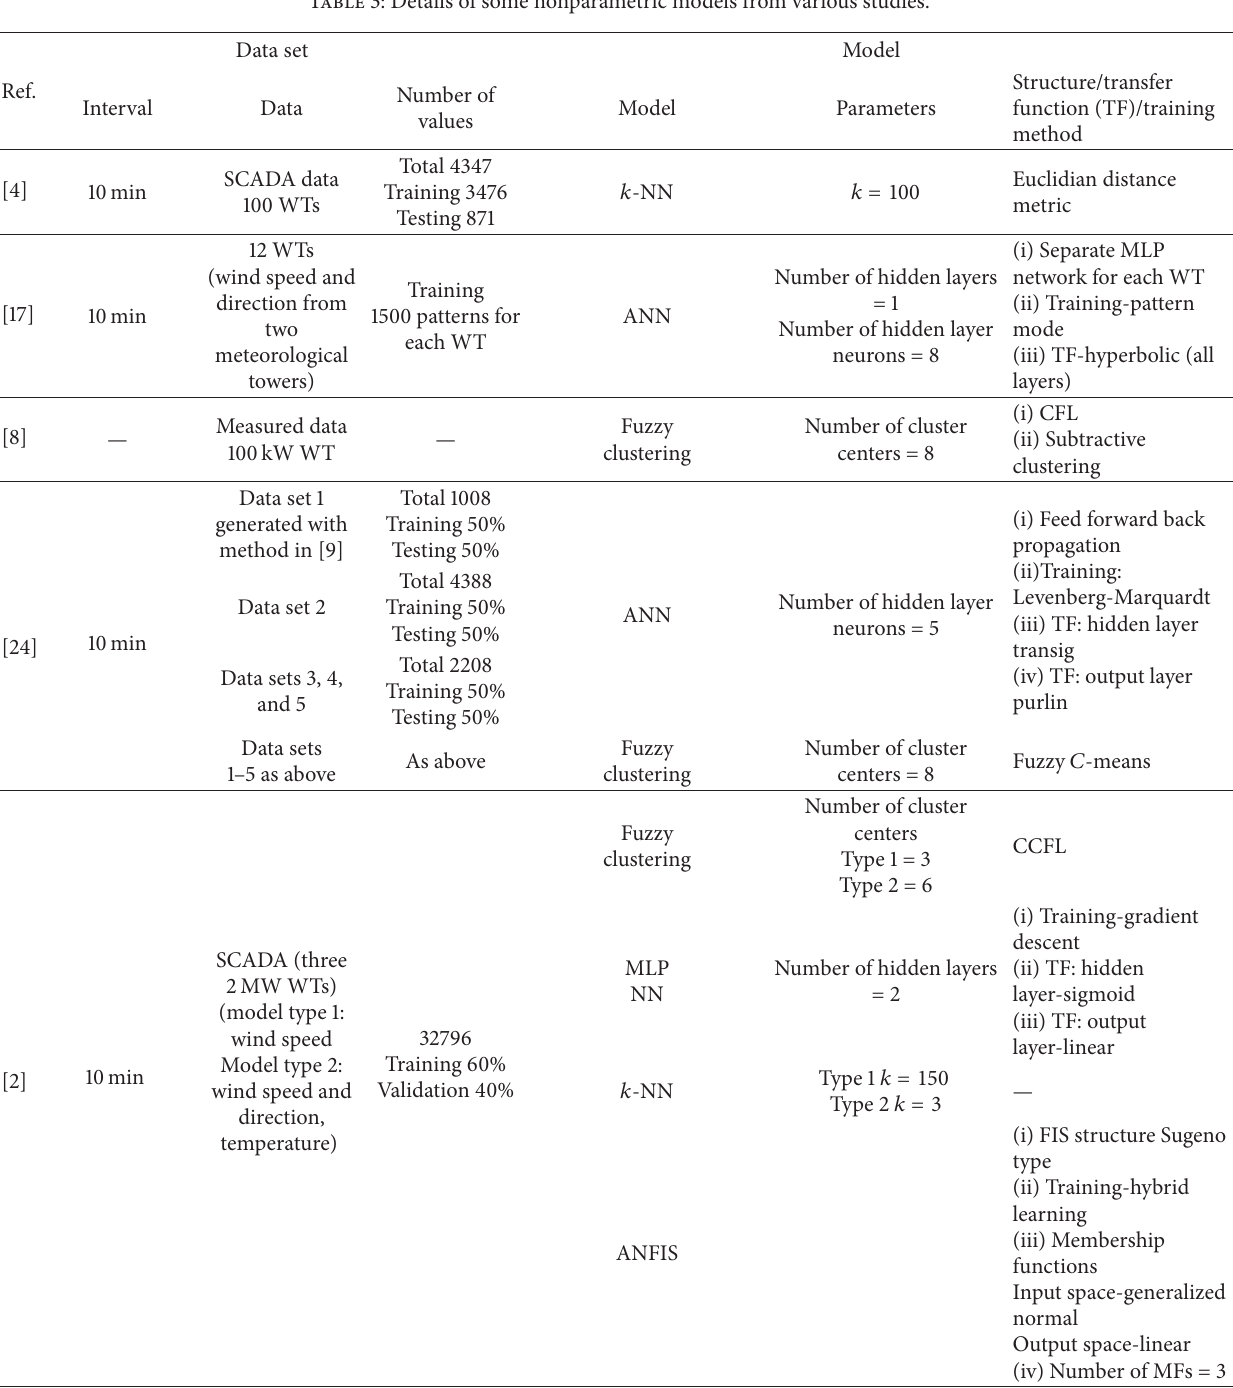
Table 3: Details of some nonparametric models from various studies.